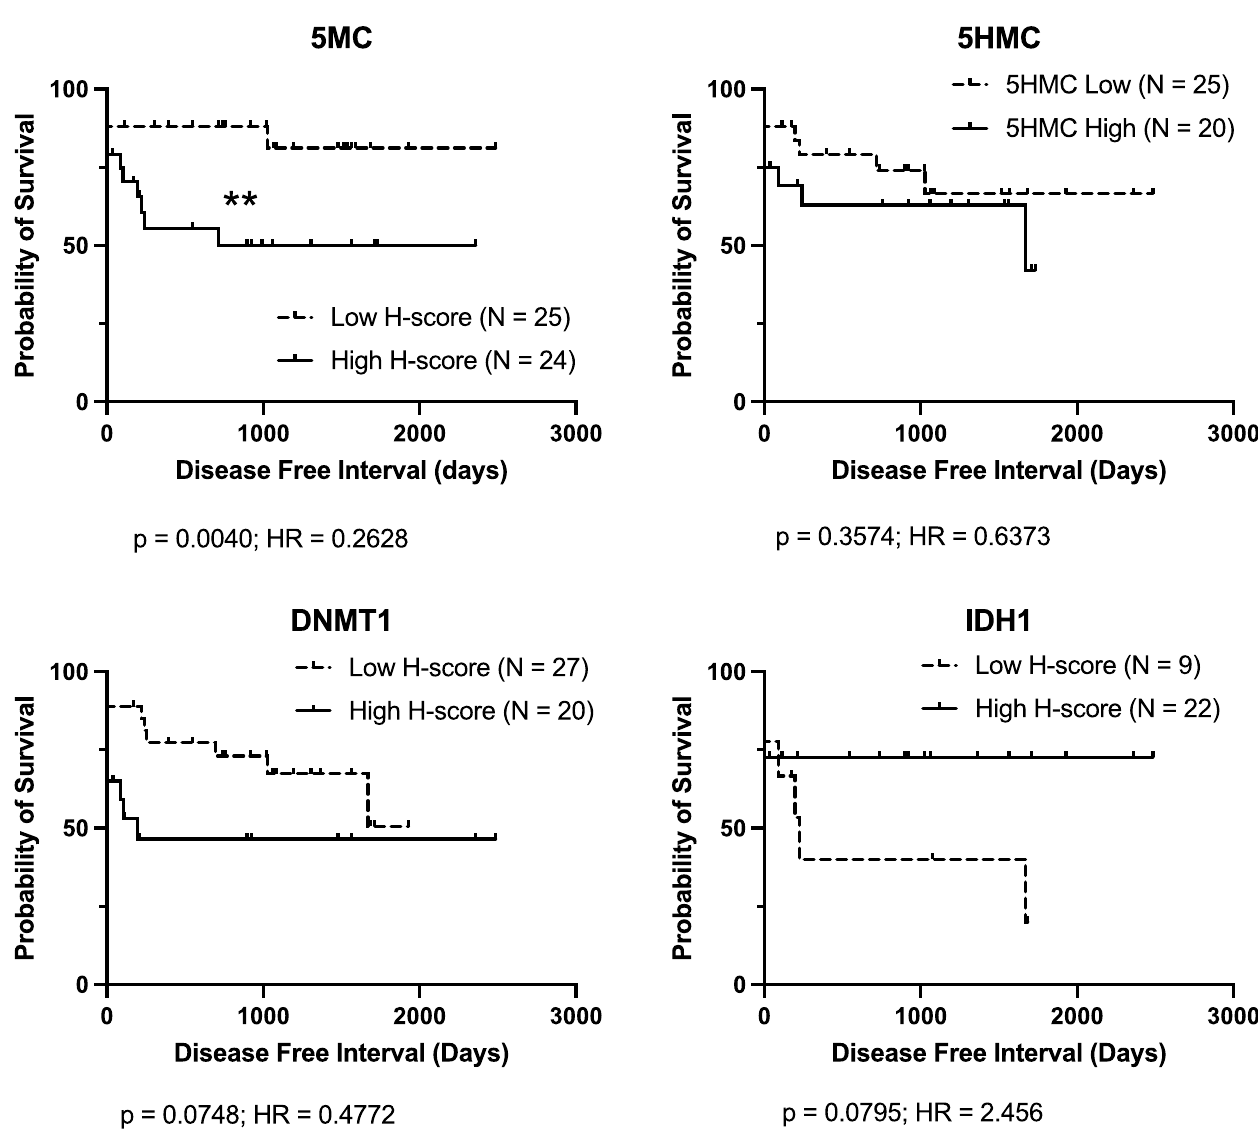
Fig 4. Kaplan-Meier survival curves for overall survival (DFI) for subcutaneous mast cell cancer cases stratified by immunolabelling H-score for each parameter. Logrank analysis indicates groups showing significant differences (p < 0.05). Cases lost to follow-up, still healthy at last follow-up, or that died of causes unrelated to MCT disease are indicated by upward ticks on the curves, and were right-censored for analysis. https://doi.org/10.1371/journal.pone.0283616.g004 Table 3. Logrank analysis of disease-free interval for Kiupel’s grading system high grade cases only. Parameter N Median Survival (Days) Hazard Ratio (95% Confidence Interval) P value 5MC Low 78 undefined 0.4845 (0.2542–0.9234) 0.0106 High 40 715 40 undefined 0.5255 (0.1843–1.499) 0.2303 undefined 0.4473 (0.1204–1.661) 0.1285 undefined 2.035 (0.4659–8.888) 0.2847